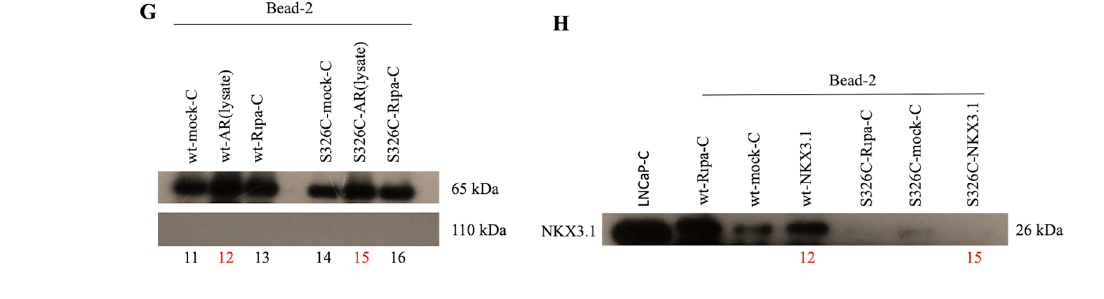
Figure 2. A. Control of GST-OGG1 (wt) and GST-OGG1 (S326C) proteins from E. coli transformants by comassie blue staining and western blot images showing protein-protein interaction analysis of GST-OGG1 (wt)/(S326C) proteins with NKX3.1 and AR. ( A ) After the in crease of GST-OGG1 (wt)/S326C) protein expression with 1 mM IPTG induction, bacterial protein isolation was performed and checked with comassie blue staining. ( B ) Control of glutathione agarose beads. ( C ) GST-OGG1 (wt) and GST-OGG1 (S326C) that precipitated with glutathione agarose beads were treated with LNCaP protein lysates. To find out if OGG1 is bound to beads and pulled down, first labeled with OGG1 antibody. ( D ) To examine protein-protein interaction, membrane immunoblotted with AR and NKX3.1 antibodies. 6 and 8 are examples that show protein-protein interaction. ( E ) Ectopic expression of AR and NKX3.1 in PC3 cells is shown. GST-OGG1 (wt) and GST-OGG1 (S326C) proteins were treated with PC3 cell lysates that expresses NKX3.1 and AR ectopically. ( F ) To find